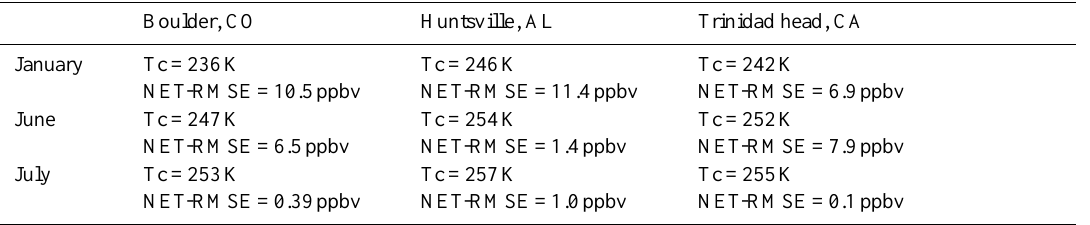
Table 2. Summary of NET-RMSE and average column temperatures for the sonde sites. Boulder, CO Huntsville, AL Trinidad head, CA January Tc=236K Tc=246K Tc=242K